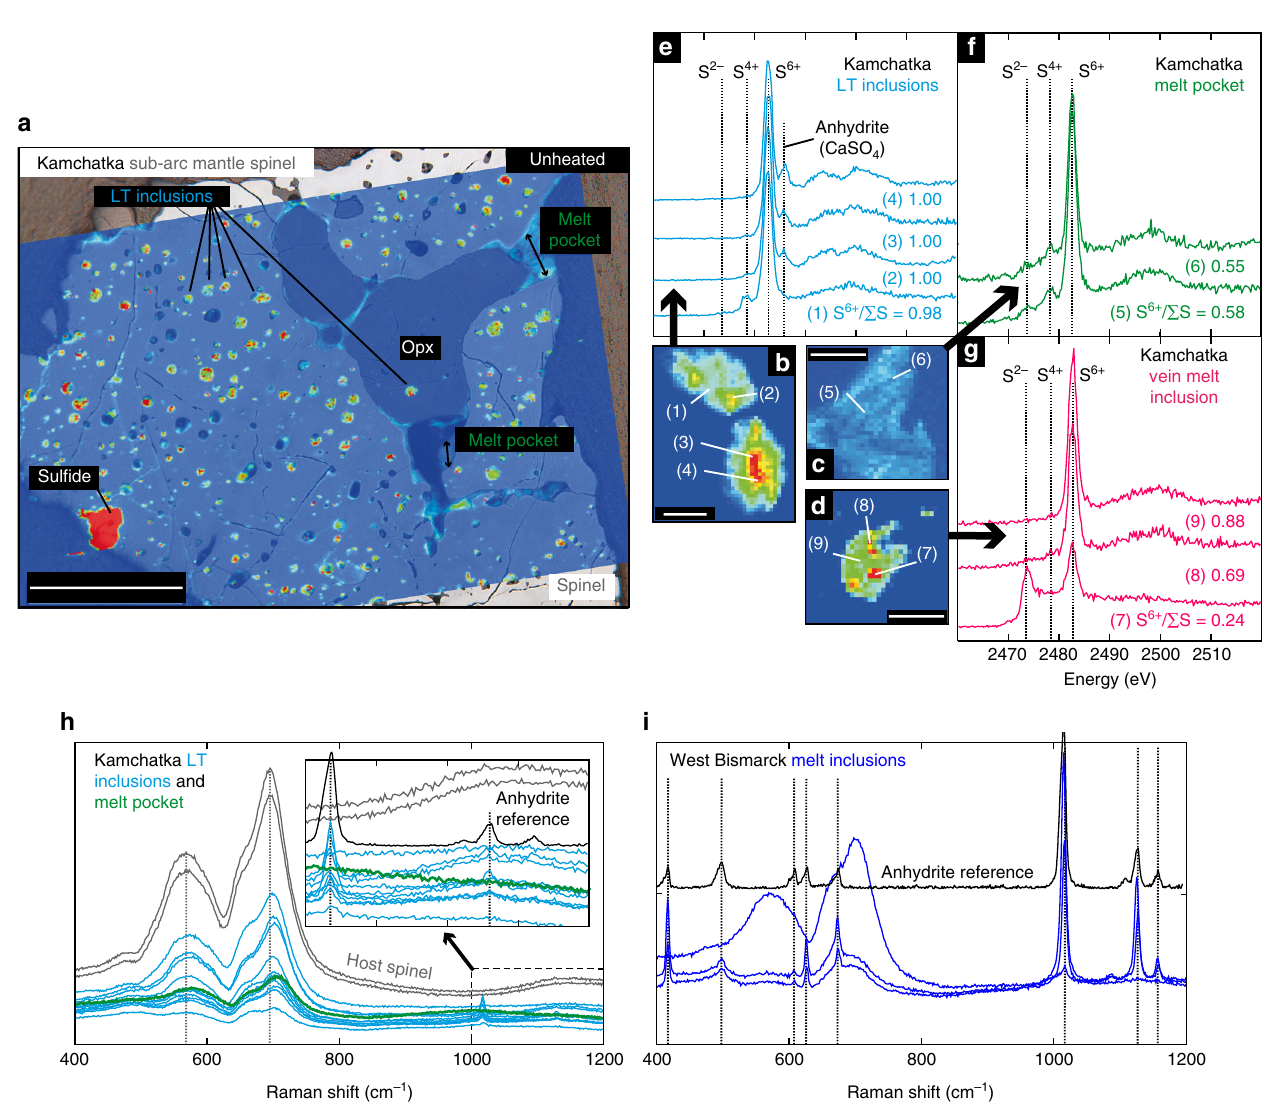
Fig. 2 Spinel-hosted glass (formerly melt) inclusions (MI) from the mantle lithosphere beneath the Kamchatka and West Bismarck arcs and their sulfur distribution and valence state. a A re fl ected-light image of a spinel grain containing many LT inclusions and MP. Coloured inlay in a shows the elemental distribution of S in the spinel, LT inclusions and MP determined by S K α X-ray fl uorescence imaging (red, high S concentration; blue, low S concentration). Note the presence of a LT inclusion in an orthopyroxene (Opx) from the host harzburgite, which supports the formation of these inclusions by pervasive percolation of their parental melts in the sub-arc mantle lithosphere. Scale bar length is ~200 µ m. b – d Uncalibrated S K α X-ray fl uorescence maps of b LT inclusions, c MP and d vein MI. The LT inclusions and vein MI are characterised by a heterogeneous distribution of sulfur. The S-free spinel appears in dark blue. Scale bar lengths are respectively ~10 µ m in b and ~20 µ m in c , d . e – g S K-edge XANES spectra of e LT inclusions, f MP and g vein MI. Spectra numbers refer to the spot positions shown in b – d . Vertical black lines indicate energies for speci fi c S valence states: 2482.8 eV for S 6 + , 2478 eV for S 4 + and 2472.5 eV for S 2 − in crystalline Fe-S compounds. The additional feature at ~2486 eV is typical for crystalline anhydrite (CaSO 4 ). Some S 4 + is generated during XANES measurements of glasses by photo-reduction of S 6 + . The LT inclusions contain solely S 6 + in glass and in anhydrite. The MP contain S 2 − and S 6 + in glass with 0.55 ≤ S 6 + / ∑ S ≤ 0.58. The vein MI dominantly contain S 6 + in the glass with S 6 + / ∑ S up to 0.88 but also show varying contributions of S 2 − from immiscible sul fi des (Supplementary Table 1). h , i Raman spectra for h multiple LT inclusions and an MP, and i West Bismarck MI, compared with their host spinel (grey spectrum) and an anhydrite (CaSO 4 ) reference (black spectrum). All these inclusions, with the exception of the MP, contain anhydrite. Note that all the inclusions for which data are presented here are